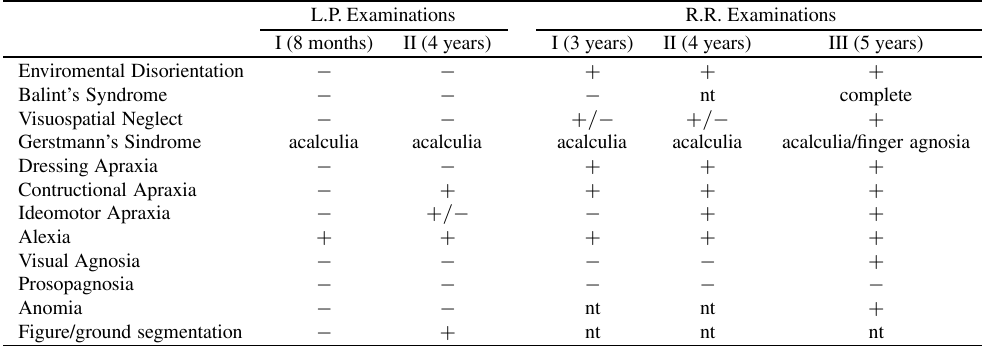
Table 2 Summary of clinical features at different examinations for L.P. and